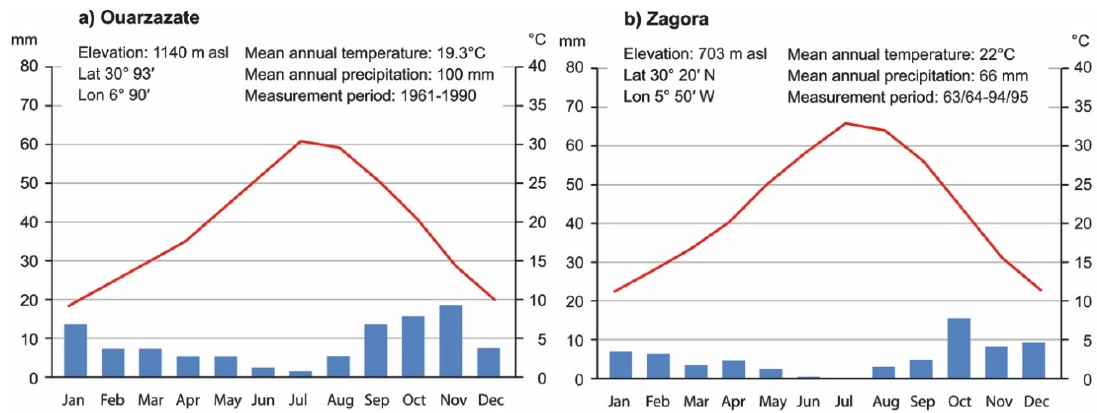
Figure 2. Climate diagram of ( a ) Ouarzazate showing lower temperatures and higher precipitation than ( b ) the city Zagora located in the south of the Drâa valley (modified from [7,24]).